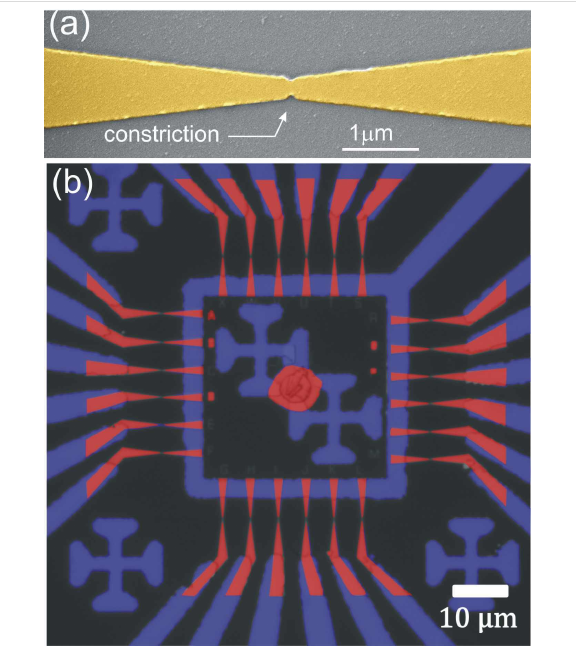
Figure 1: (a) False-color scanning electron micrograph of a typical constriction separating two tapered electrodes. The yellow color indi- cates the Au part. The constriction is 150 nm wide for a length of 70 nm. (b) False-color image of a series of constrictions and their elec- trical connections. The areas colored in red are made by electron- beam lithography, the regions in blue are those fabricated by photolith-